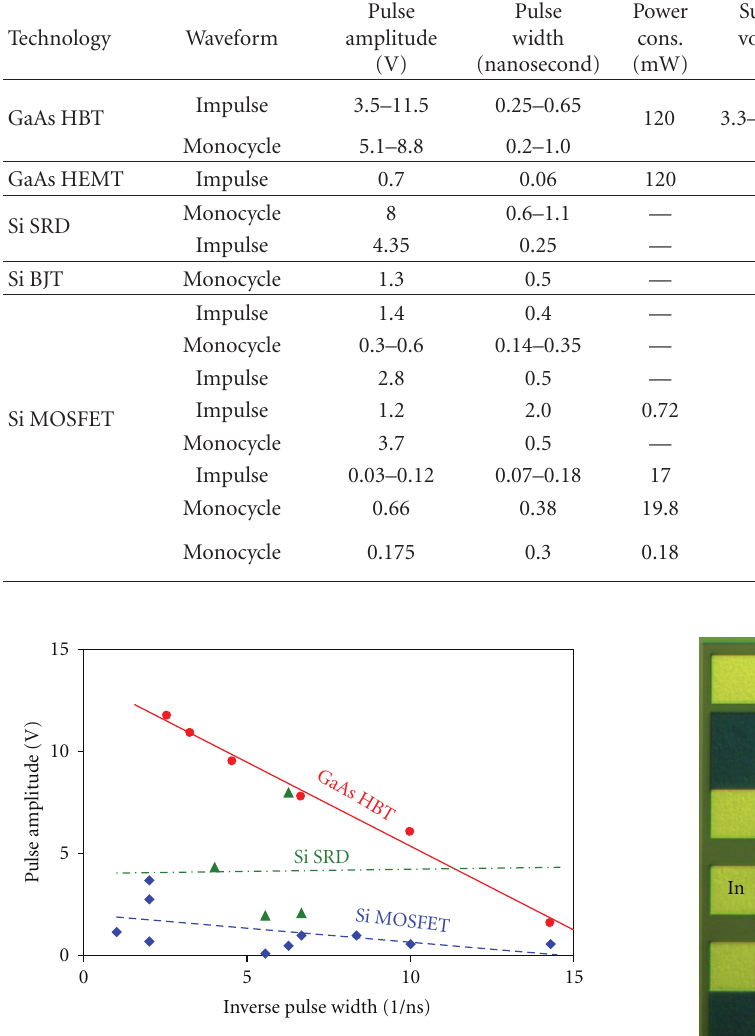
Figure 1: Output pulse amplitude as a function of inverse pulse width for UWB pulse generators of di ff erent technologies.